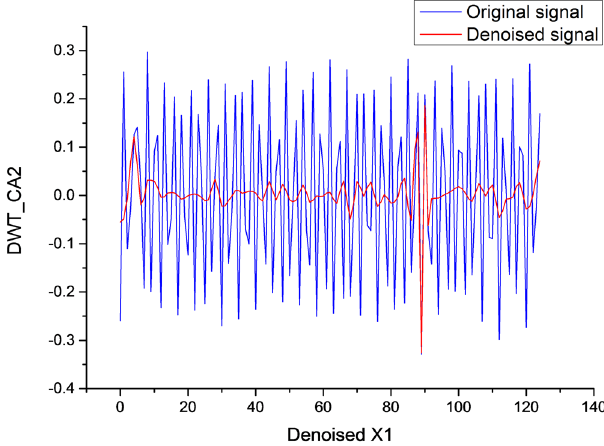
Figure 9. Original ECG signals twice filtered through the band-pass